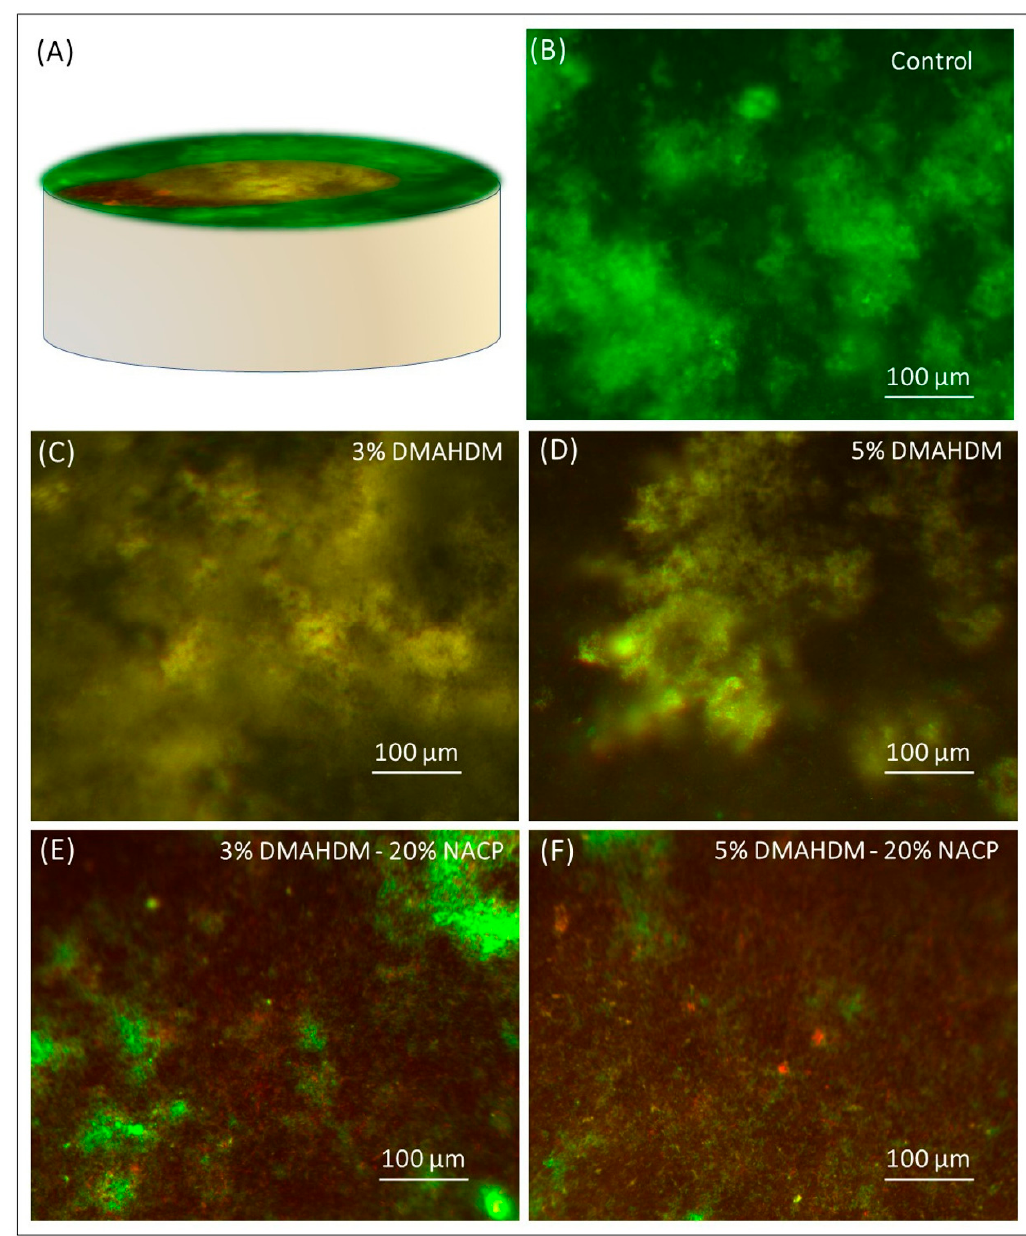
Figure 5. The live/dead images for the biofilms formed over the composites’ surface (n = 3). ( A ) A schematic drawing showing the accumulation of the biofilm over the composite surface. Live bacteria were stained green, and compromised bacteria were stained red. The higher amount of viable microorganisms was associated with the experimental control group ( B ), followed by the 3% and 5% DMAHDM ( C , D ). The minimum load of viable bacteria was observed over the DMAHDM-NACP groups ( E , F ).